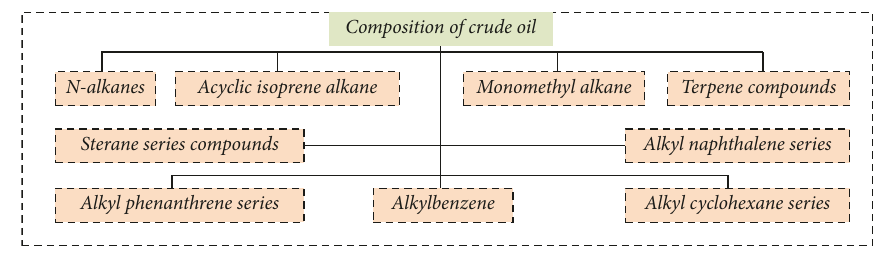
Figure 2: Composition of crude